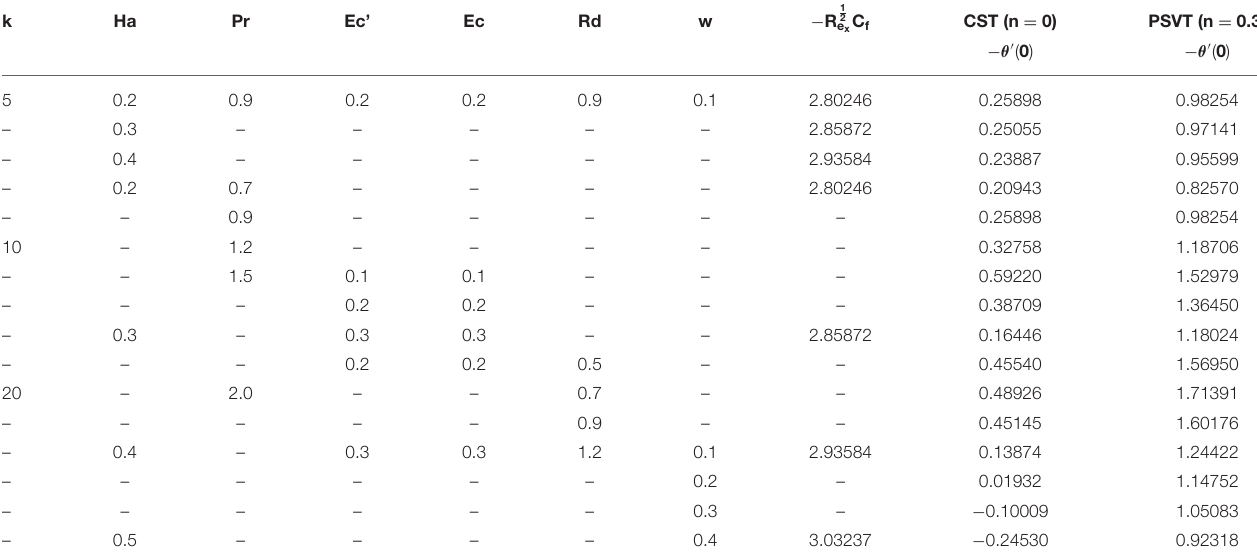
1 2 e x C f and rate of heat transfer at fixed a = 0.5, and b =